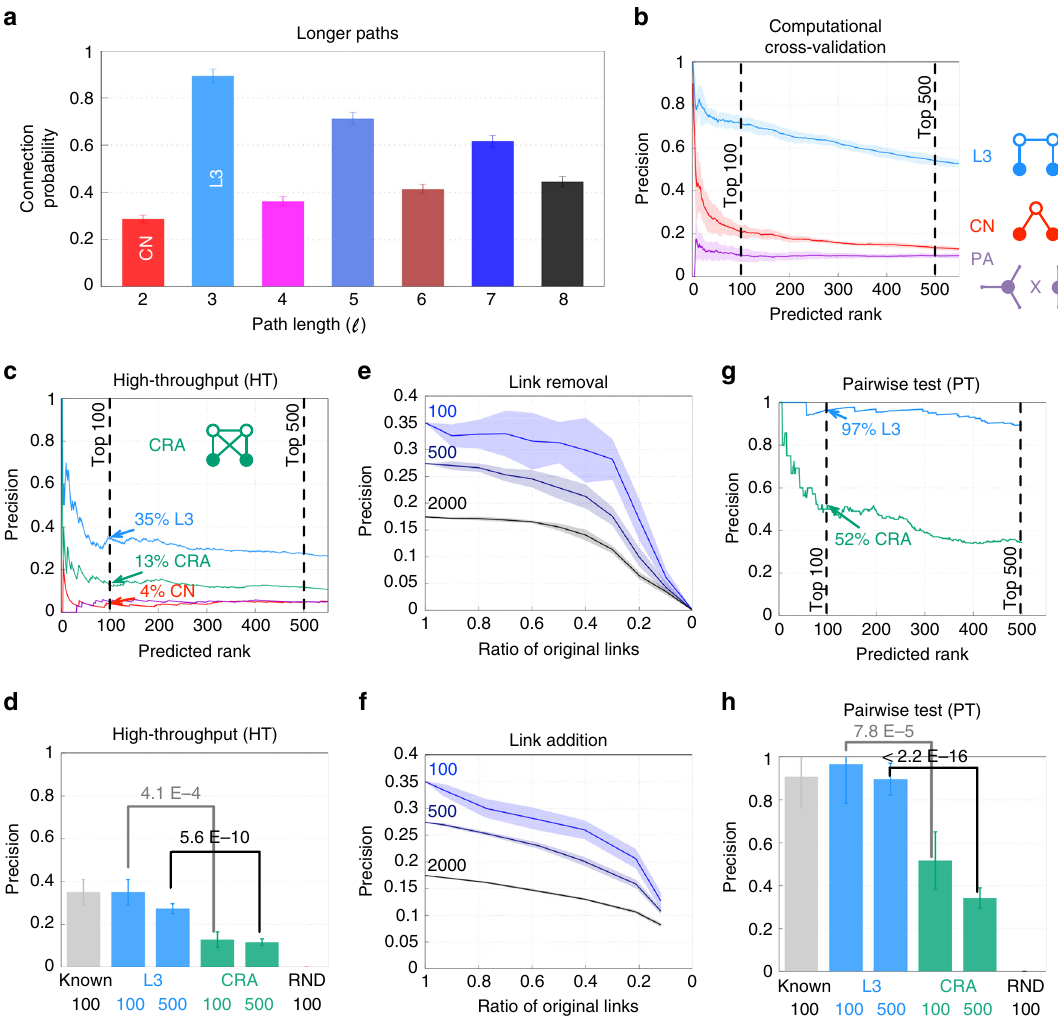
Fig. 3 L3 is a precise and robust tool to fi nd missing PPIs. a Connection probability in the top 1,000 HI-II-14 5 protein pairs ranked by different powers of the adjacency matrix, ‘ , counting all paths of length ‘ ¼ 2 ; ¼ ; 8. ‘ ¼ 3 paths are the most informative on direct connectivity. b In a 2-fold computational cross- validation on HI-tested (see the Methods section for details) L3 outperforms CN and PA at least three-fold. c In a high-throughput (HT) setting, we tested the L3 predictions on HI-tested, against the human interactome, HI-III 26 . L3 outperforms all other methods several fold, including the best performing literature method, CRA 29 , out of 23 different methods tested (Supplementary Figures 5 and 6). d As a positive benchmark, we selected 100 known interactions (Known) and as a negative benchmark, 100 random pairs (RND), to set the expected window of precision values. For details see the Methods section. The recovery rate (precision) of L3 is signi fi cantly higher than that of CRA and comparable to the one of Known interactions (one-sided Fisher ’